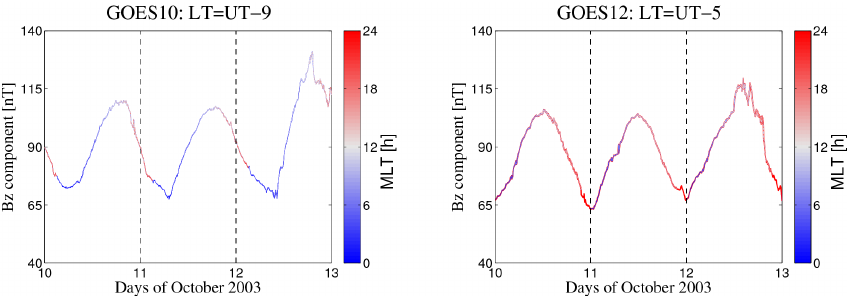
Figure 5. SSQ, 10–12 October 2003: magnetospheric observations at geosynchronous orbit for GOES10 (LT = UT − 9; left panel) and GOES12 (LT = UT − 5; right panel) spacecraft. The time resolution is 1min.